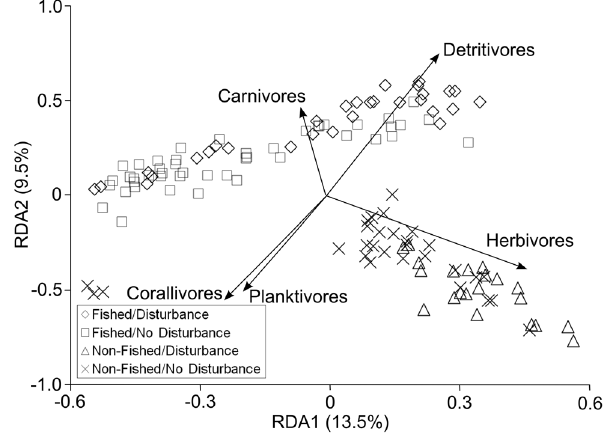
Figure 3. Redundancy analysis of species composition (n=112) for five trophic groups (carnivore, herbivore, detritivore, corallivore and planktivore) of reef fishes. Sites have been classified by the four treatments and the variation explained by each axis is shown.